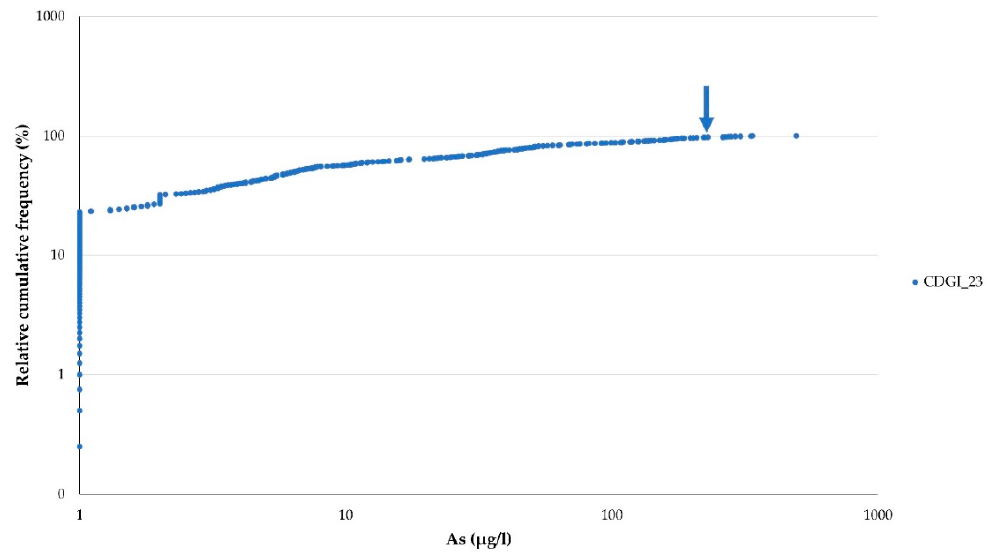
Figure 6. Cumulative relative frequencies of arsenic (As) for the groundwater body CDGI_23. Arrow indicates value x considered for the calculation of Mean + 2SD and Median + 2MAD ranges.